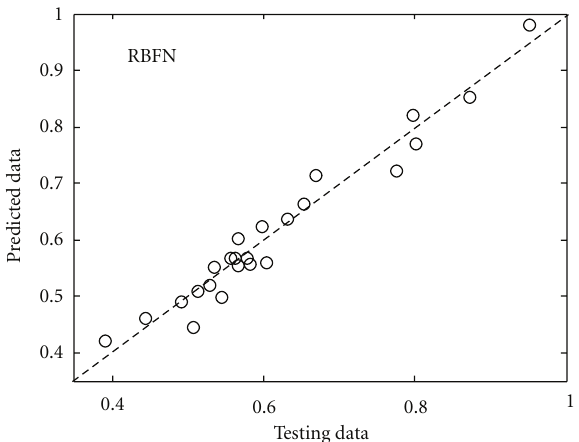
Figure 8: Scatter diagram of the testing and predicted data,